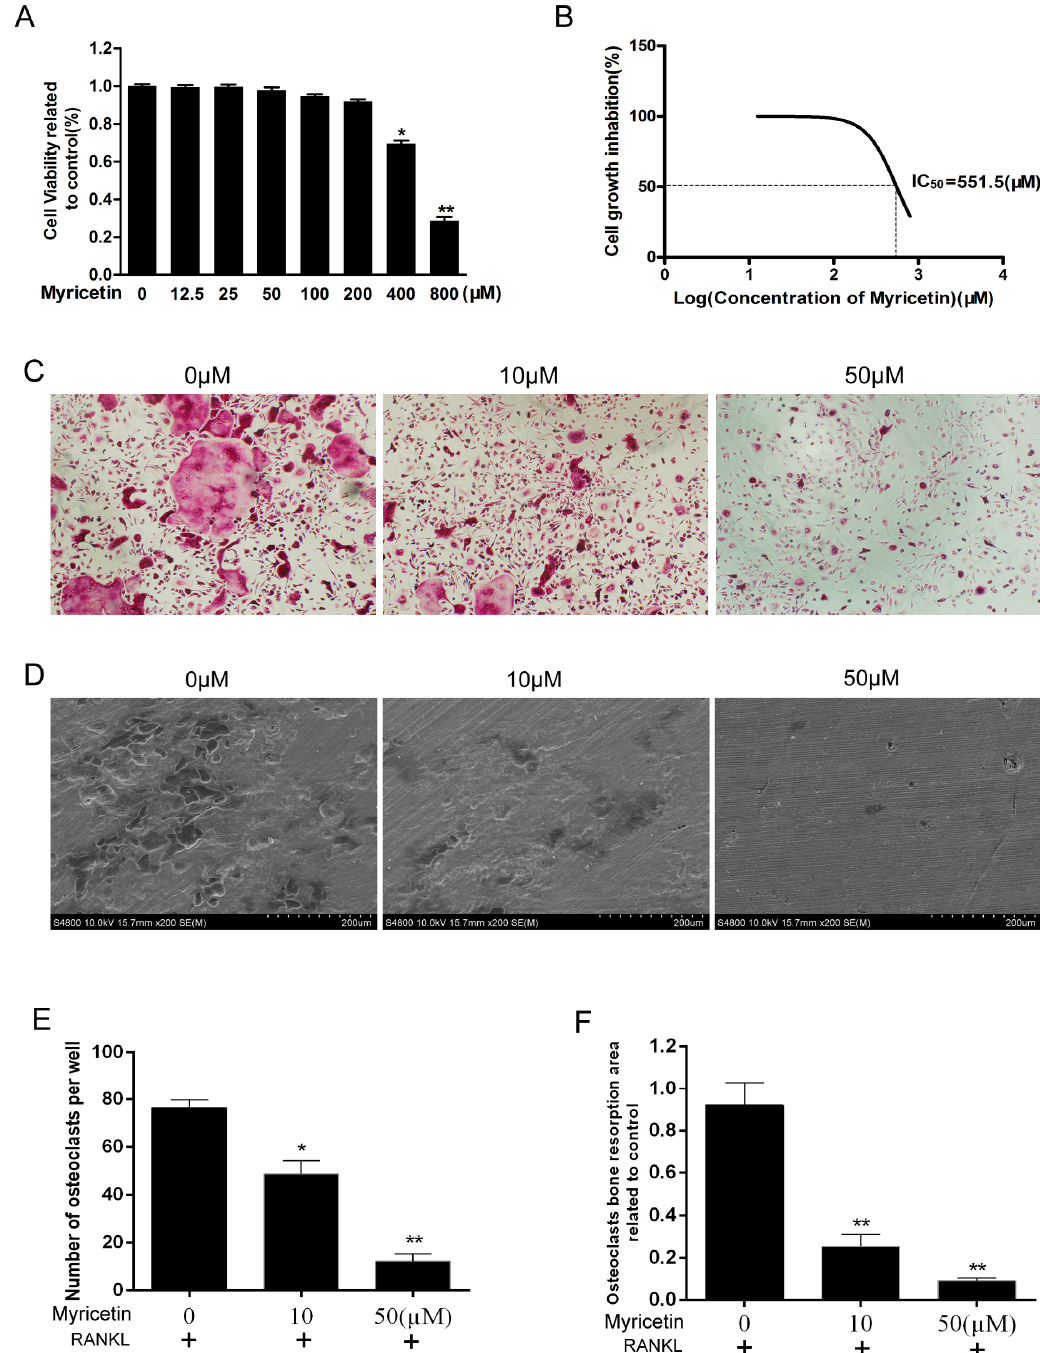
Figure 5. Myricetin inhibited receptor activator of nuclear factor κ -B ligand (RANKL)-induced osteoclastogenesis and osteoclast-mediated bone resorption without cytotoxicity. ( A ) RAW264.7 cells were treated with 50 ng/mL RANKL, and indicated concentrations of myricetin for 96 h prior to measuring cell viability using Cell Counting Kit-8 (CCK8) assay; * p < 0.05, ** p < 0.017 ( n = 3); ( B ) Inhibition rate of RAW264.7 cells was calculated (GraphPad Prism), and the half-maximal inhibitory concentration (IC 50 ) was determined as 551.5 μ M; ( C ) RAW264.7 cells were treated with indicated concentrations of myricetin and 50 ng/mL RANKL, respectively for 5 days. Cells were fixed with 4% ( w / v ) paraformaldehyde and stained for TRAP; ( D ) Representative scanning electron microscopy (SEM) images of bone-resorption pits are shown; ( E ) Number of TRAP-positive cells; ( F ) Total area of resorption pits measured using Image J; * p < 0.05, ** p < 0.017 ( n = 3).